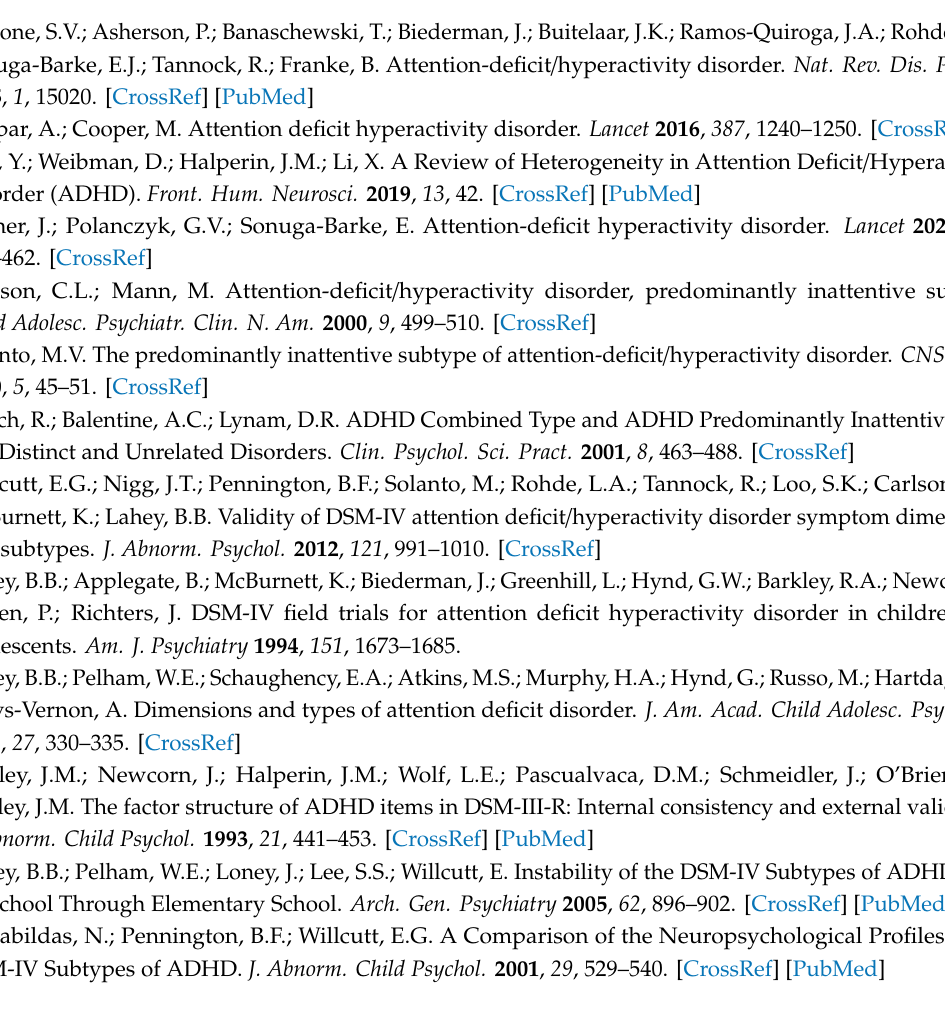
Table S1: Systematic search process and terms for study